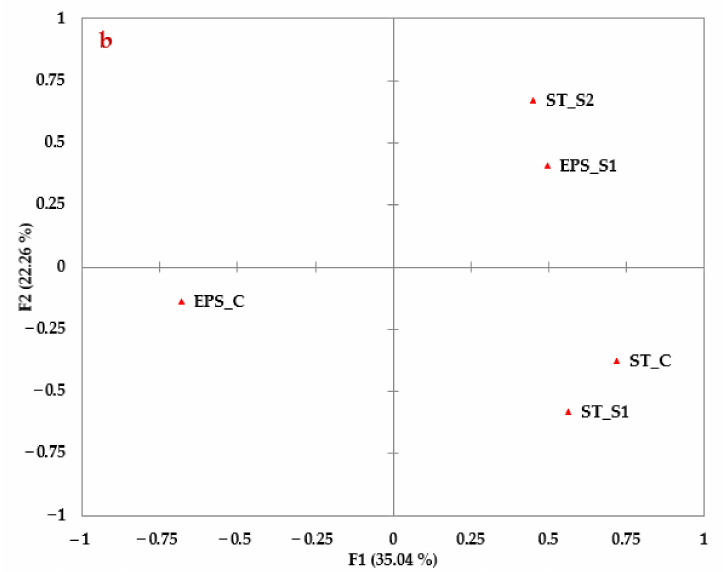
Figure 4. Principal component analysis plots relating EPS production, sodic tolerance, and bacterial isolates. ( a ) Biplot showing the position of active observation (bacterial isolates). ( b ) Biplot showing the position of active variables on F1 and F2. ST_C—sodic tolerance for control, ST_S1—sodic tolerance @ 0.5% Na 2 CO 3 , ST_S2—sodic tolerance @ 0.75% Na 2 CO 3 , EPS_C—EPS production